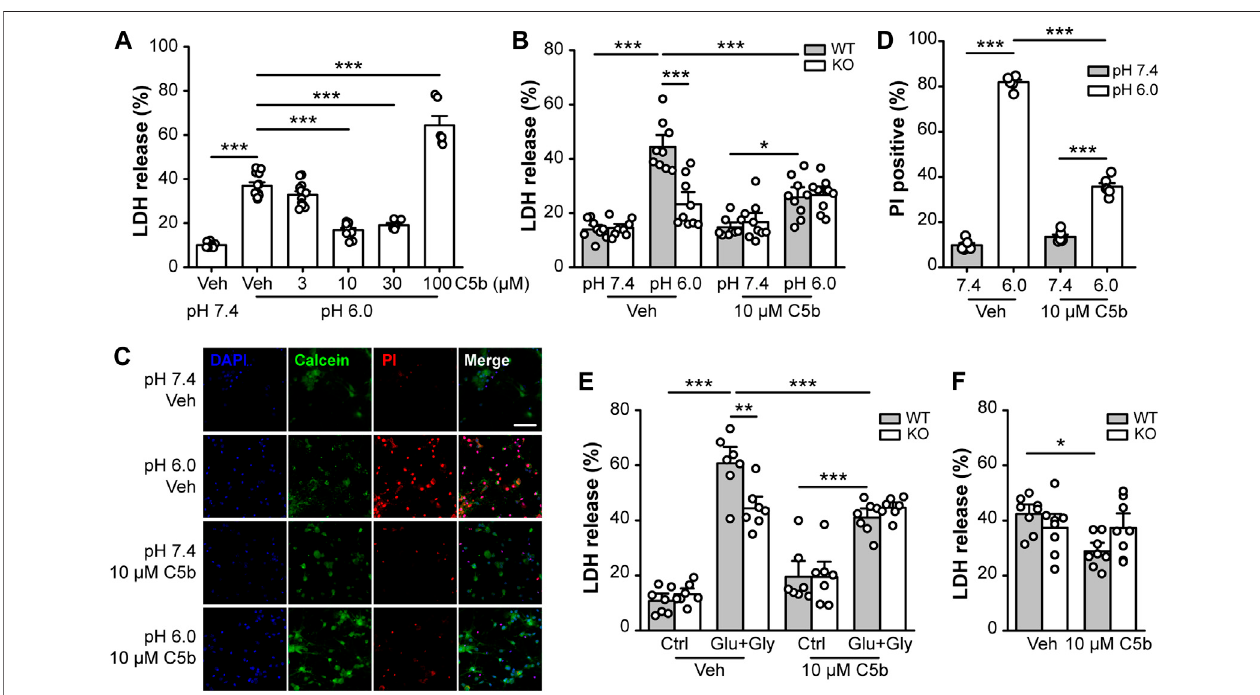
FIGURE 2 | C5b protected neurons from ASIC1a-dependent cell death. (A) Concentration dependence on C5b of the protective effect against acid (pH 6.0)- induced neuronal death as detected by the LDH release assay. Mouse cortical neurons were treated with a pH 6.0 ECF for 1 h and then returned to the normal culture medium for 24 h C5b was present during the acid treatment but was omitted during the recovery period. n = 5 or 9 for each group. Statistical signi fi cance was determined with one-way ANOVA for differences across groups at different doses in conjunction with Tukey test for means comparison. *** p < 0.001. (B) C5b (10 µM) inhibited acid (pH 6.0)-induceddeath ofWT primary cortical neurons, but had no effecton Asic1a KO neurons. n = 9 for each group. (C) Representative images of mouse cortical neurons treated with pH 7.4 and pH 6.0 ECF, with cell death detected by Calcein ( green ) and PI ( red ) staining. DAPI ( blue ) staining was used for cell counting. Neurons were treatedwith vehicle (veh) orC5b (10 µM). Scale bar,20 μ m. (D) Statisticsfor (C) showing that10 μ MC5b dramatically reducedPI-positive cells undertheconditionof1 hacidosisfollowedby24 hreperfusion. n =6foreachgroup. (E) C5b(10 µM)suppressedglutamate-inducedneuronaldeathinWTneuronsbut had no effect on Asic1a KO neurons. Excitotoxic death was induced by a treatment of 10 μ M glycine and 1 mM glutamate for 1 h followed by returning to the normal culturemediumfor24 h. n =7for each group. (F) C5b (10 µM) attenuated neuronal death induced byOGD inWT neurons but had noeffect on Asic1a KO neurons. Cell deathwasinducedbyOGDfor1 hfollowedbyreoxygenationfor24 h. n =8foreachgroup.Alldataarepooledfromtwotofourindependentexperimentsandareshown as mean ± SEM. In (B – F) , statistical analysis was performed by two-way ANOVA followed by the Tukey test to identify signi fi cant treatment and genotype factors and their interactions. * p < 0.05, ** p < 0.01, *** p <